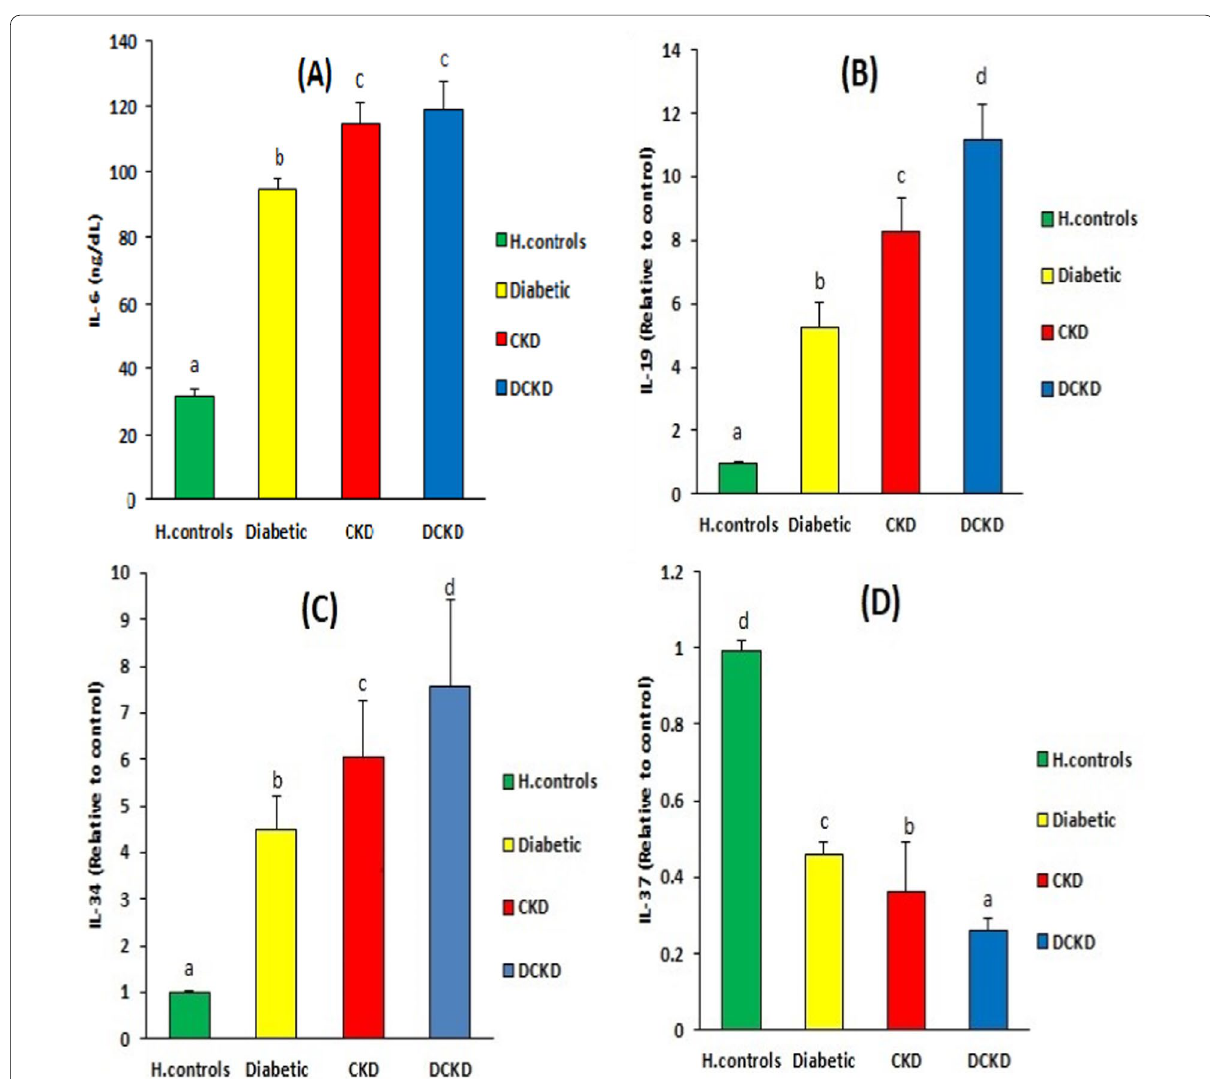
Fig. 3 The levels of A IL‑6, B IL‑19 expression, C IL‑34 expression, D IL‑37 expression in healthy control, chronic kidney dysfunction (CKD), and diabetic chronic kidney dysfunction (DCKD) groups. Data are represented as mean Healthy, IL‑6: interleukin‑6, IL‑19: interleukin‑19, IL‑34: interleukin‑34, IL‑37: